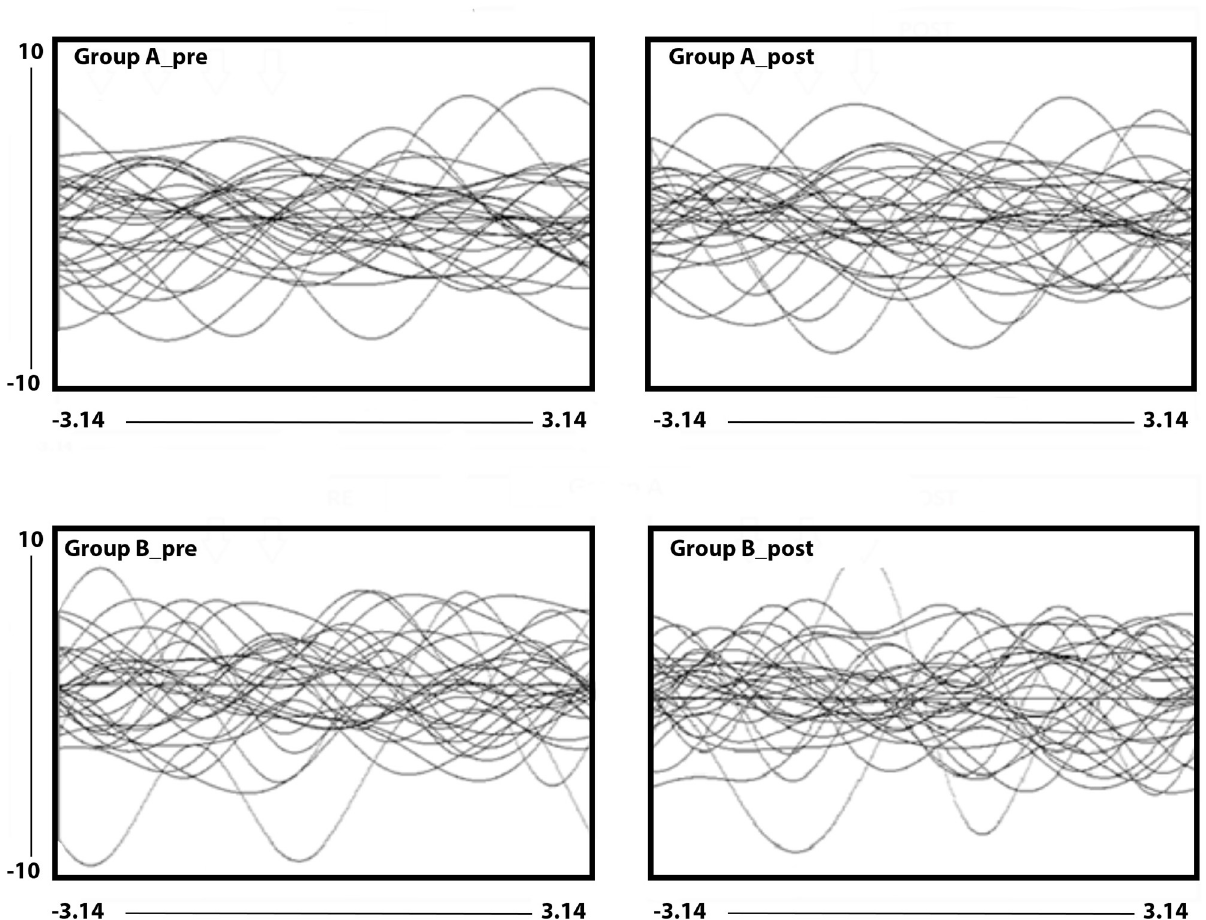
Fig 1. Graphical representation of the PESF effects on some laboratory tests through the Andrews curves which have been constructed with the first 5 principal components (CP) equal to 92% of the total variance. Each curve represents a single individual (group A, pre and post PESF; group B, pre and post simulated PESF). Common laboratory tests (azotaemia, creatinine, uricemia, haemoglobin and albumin) were used for each curve. The end of the graphs is: along the X axis: -3.14 and 3.14 and along the Y axis: -10 and